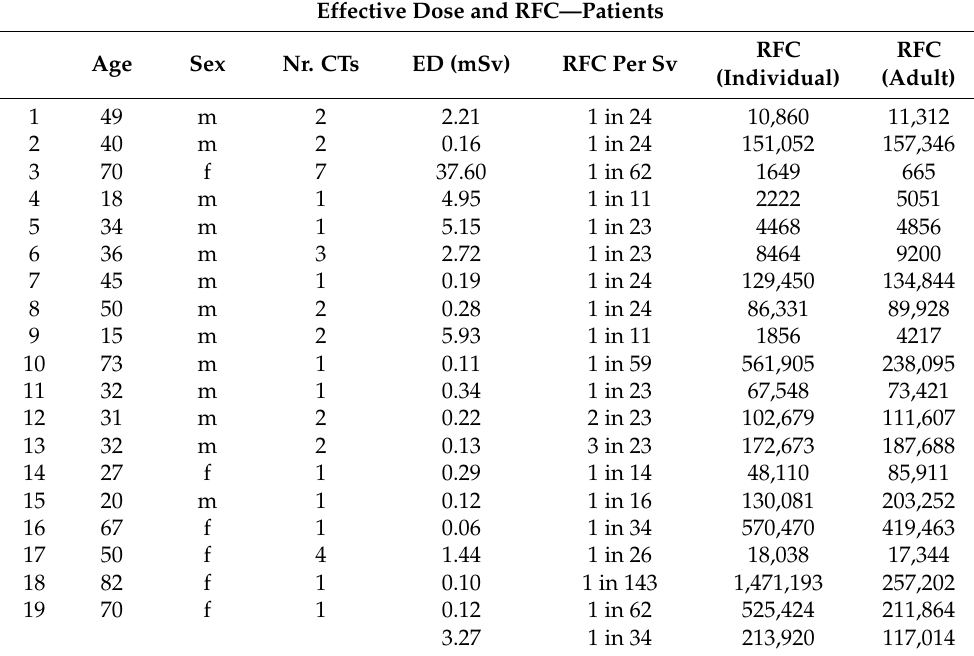
Table 4. Patient list with measured effective dose (ED), risk of induced fatal cancer (RFC) per Sv (1000 mSv), individual patient-specific risk, and risk for an adult person (1 in 25 per Sv).